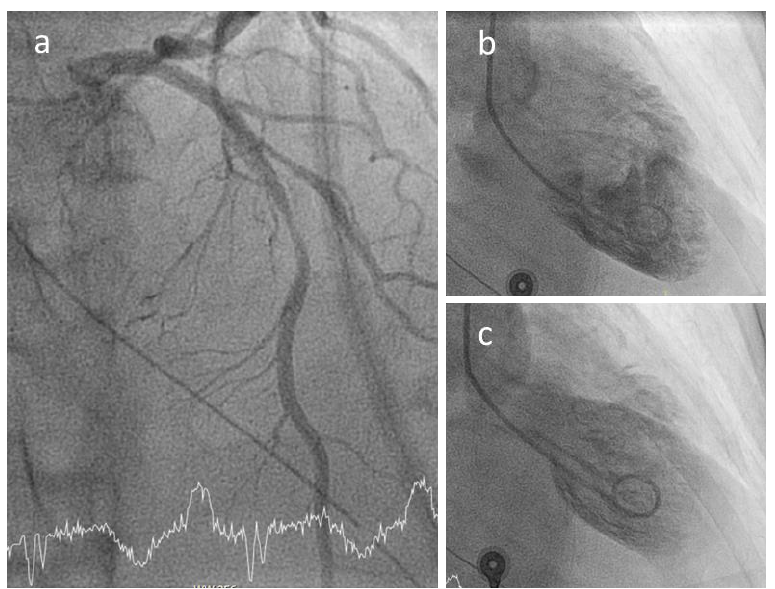
Figure 4. Coronary spasm in a 51-year-old female patient with ANCA-associated vasculitis and spasm of the proximal left anterior descending (panel a ) causing a Tako-Tsubo-like contractile dysfunction ( b , c ).